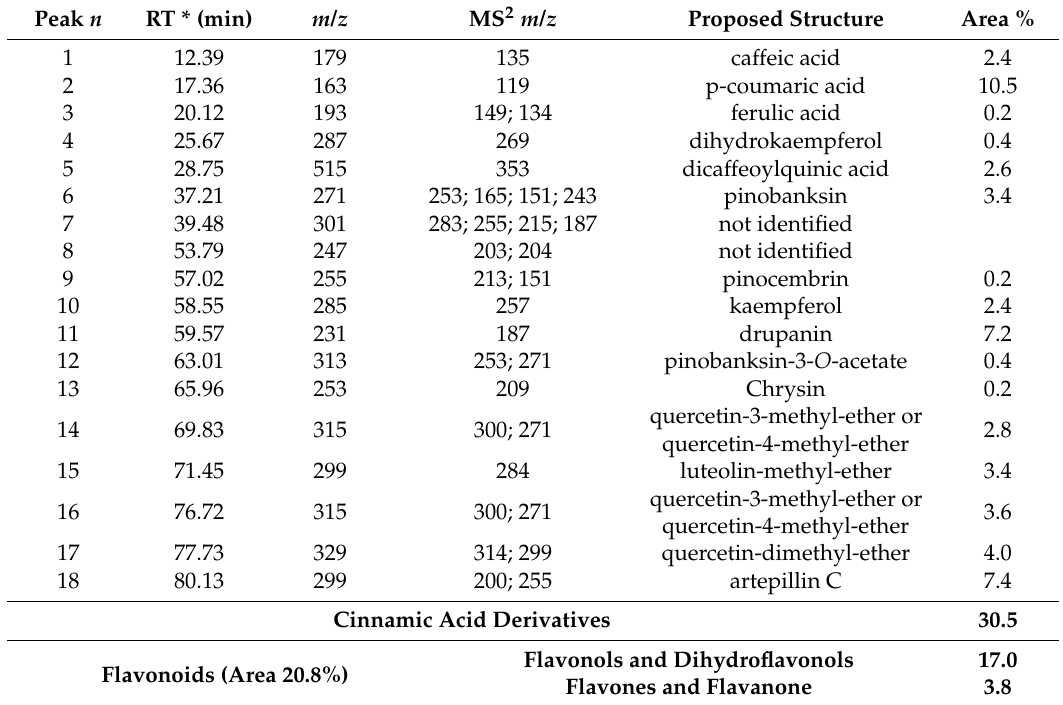
Table 2. Identified compounds in green propolis by RP-HPLC-PDA-ESI-MSn analyses, registered at 330 nm.